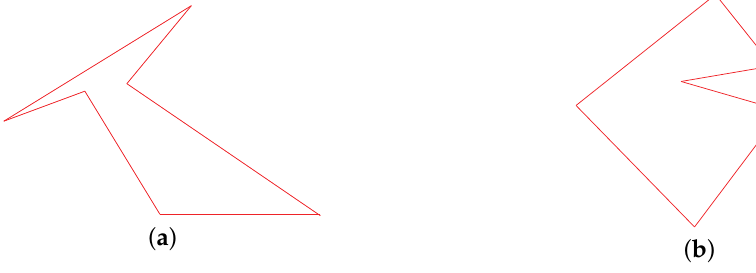
Figure 2. ( a ) Initial inverted hexagonal element. ( b ) Hexagonal element after applying the transformation in Reference [30] for one hundred